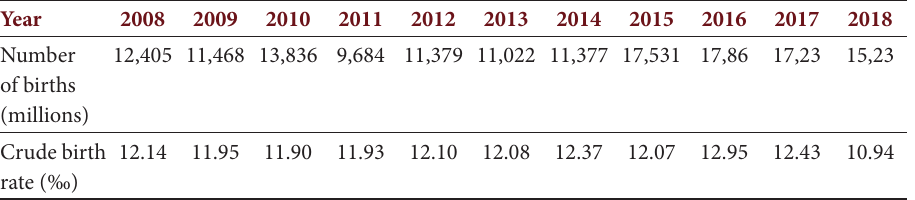
The data source: China National Bureau of Statistics. The data for 2015 is from the 1% sample survey data, other data is 0.1% of the sample survey data of each province and the data in 2010 is from nationwide census.